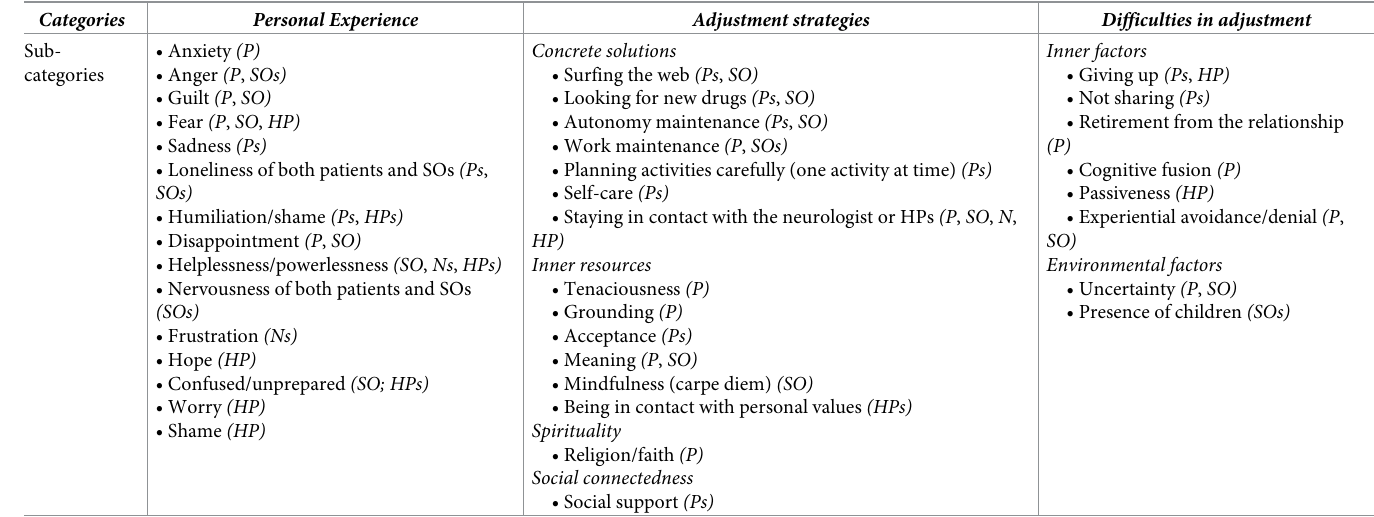
Table 4. Theme 3: Dealing with symptoms worsening. HP, health professional; N, neurologist; SO, patient significant